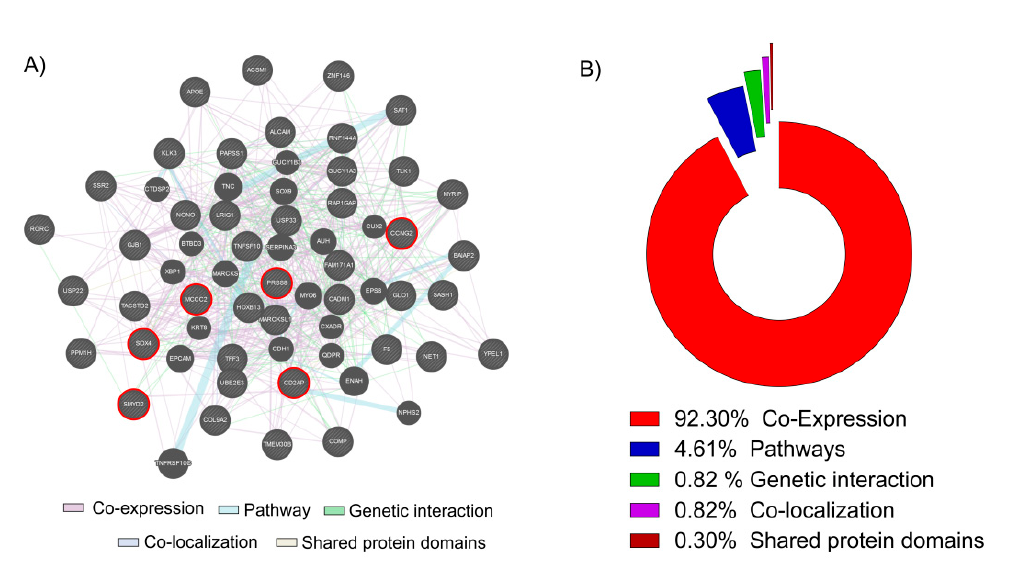
Figure 2. Network and GO analysis by GeneMania. ( A ) The 43 key genes up-regulated in PCa biopsies and down-regulated in the LNCaP cell line treated with Vitamin D (100 nM for 24 h) were loaded into GeneMania, in order to generate a GO and a Regulatory molecular network. Red circle genes represent the six most significantly up-regulated in PCa and down-regulated by the action of Vitamin D in our LNCaP cell line ( B ). The analysis showed that 92.30% of genes resulted co-expressed, 4.61% belonging to the same pathways, 1.97% present a genetic interaction, 0.82% were co-localizated and 0.30% shared the same protein domains.